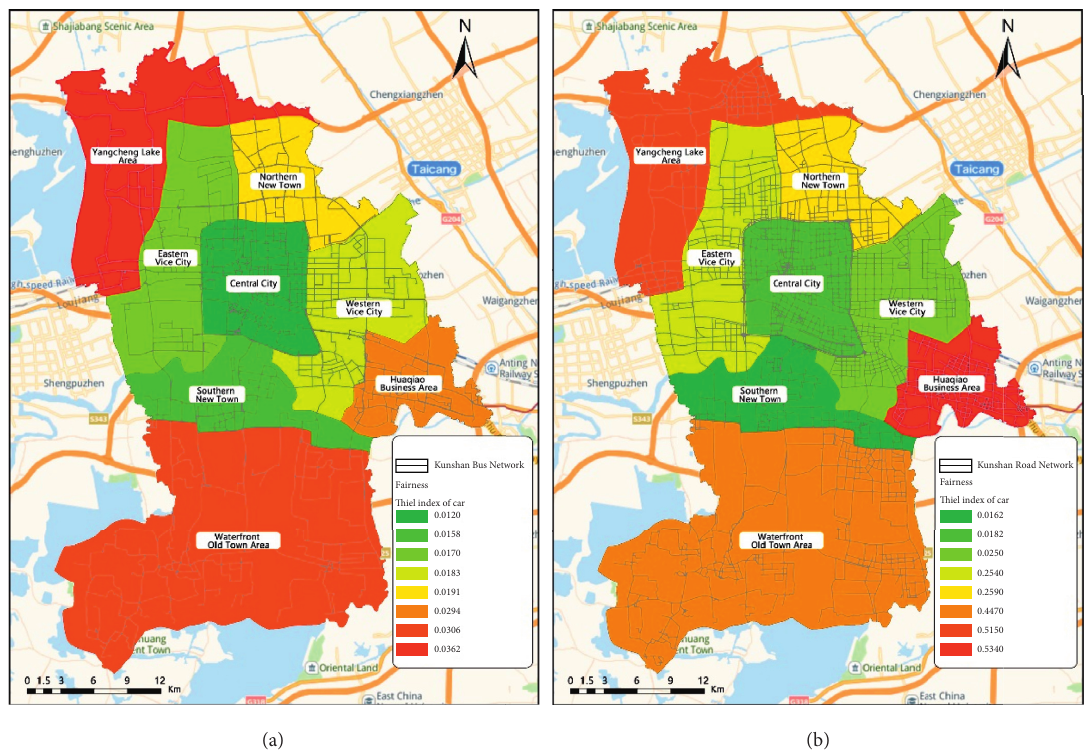
Figure 6: Spatial distribution of the Theil index: (a) public transport and (b)